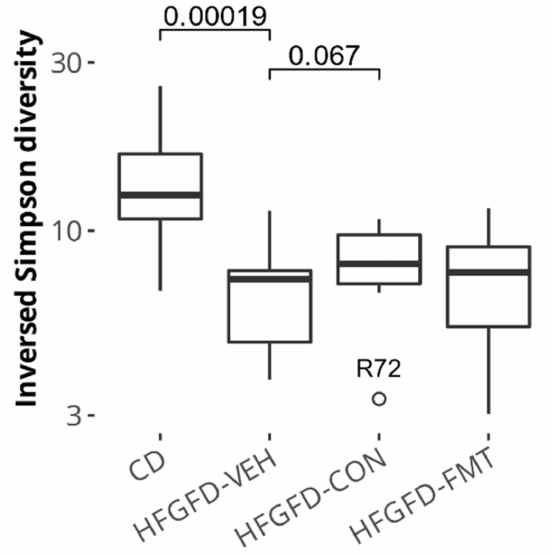
Figure 4. Microbial diversity in the cecum of NASH rats. Statistically significant differences are depicted above boxplots; these represent Wilcoxon signed–rank test p -values computed without the outlier R72. HFGFD-VEH: group of NASH rats receiving sham gavage (vehicle); HFGFD-CON: group of NASH rats receiving the 9-strain bacterial consortium daily; HFGFD-FMT: group of NASH rats receiving fecal microbiota transplantation from control lean rats (1 × transplantation followed by sham